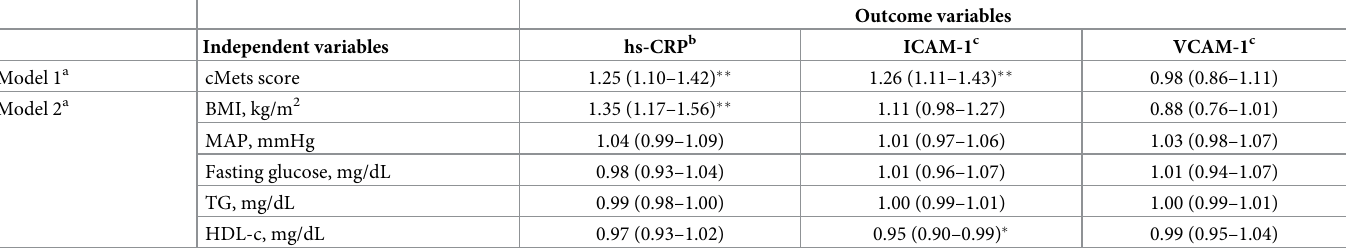
Table 5. Adjusted odds ratios for endothelial dysfunction and risk of acute inflammation according to the metabolic syndrome score and its components in adolescents.